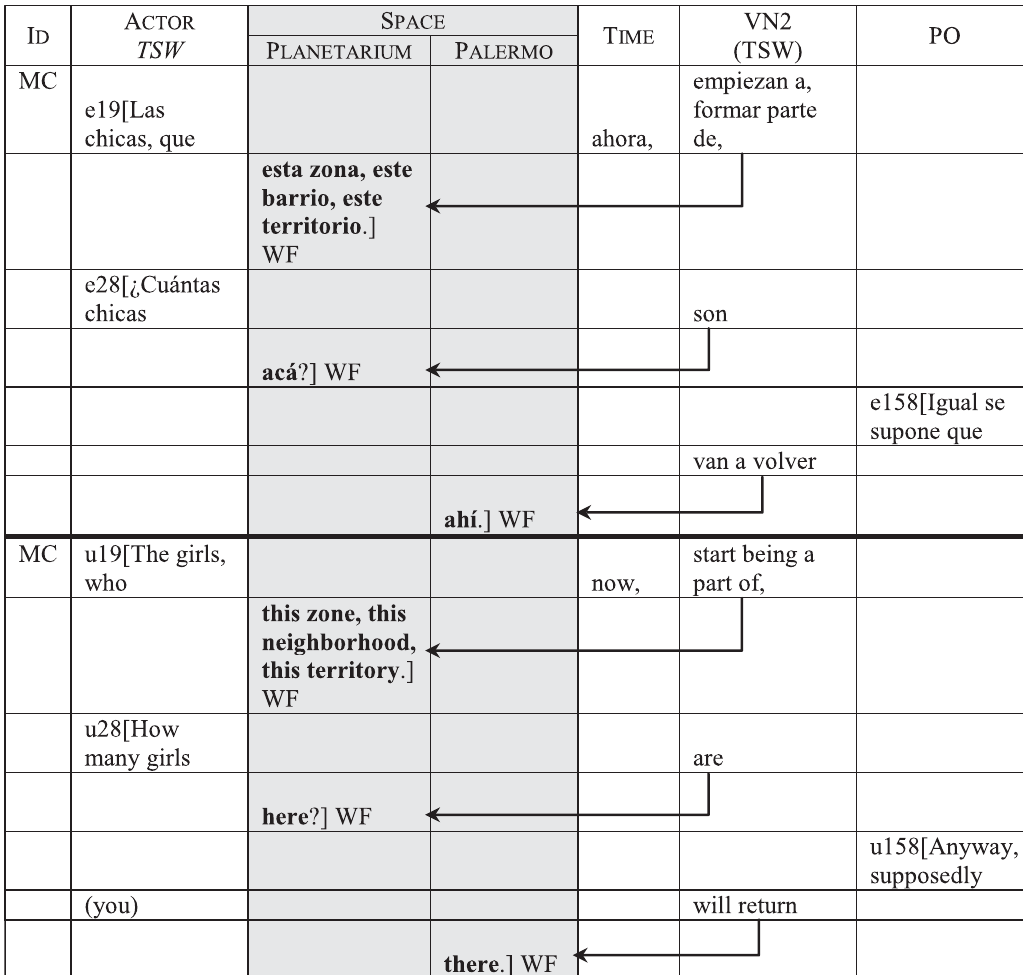
TABLE 6 | The representation of the transgender sex workers in relation with Space